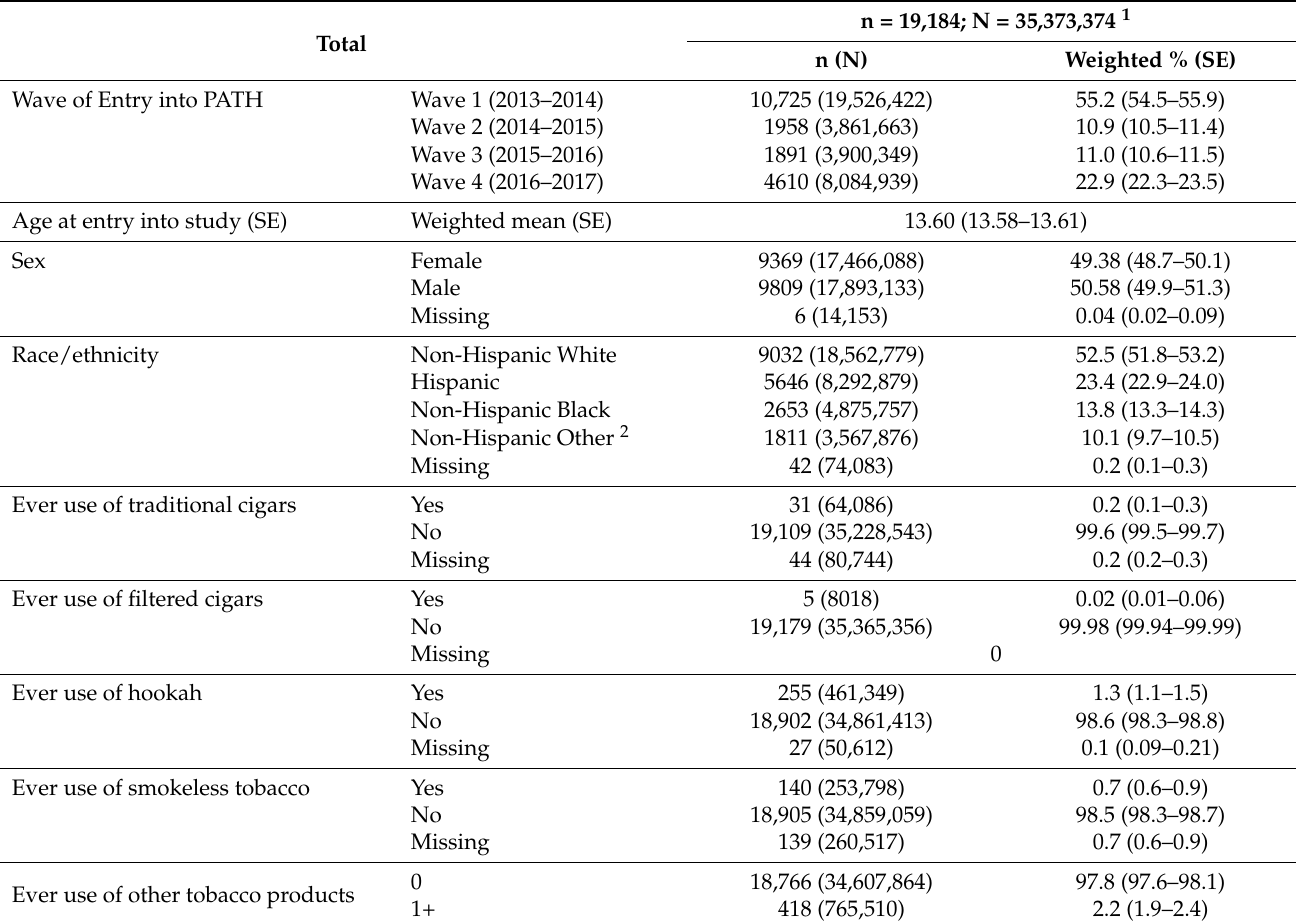
Table 1. Demographic characteristics of PATH ¥ youth (aged 12–17) never users at their first wave of participation.